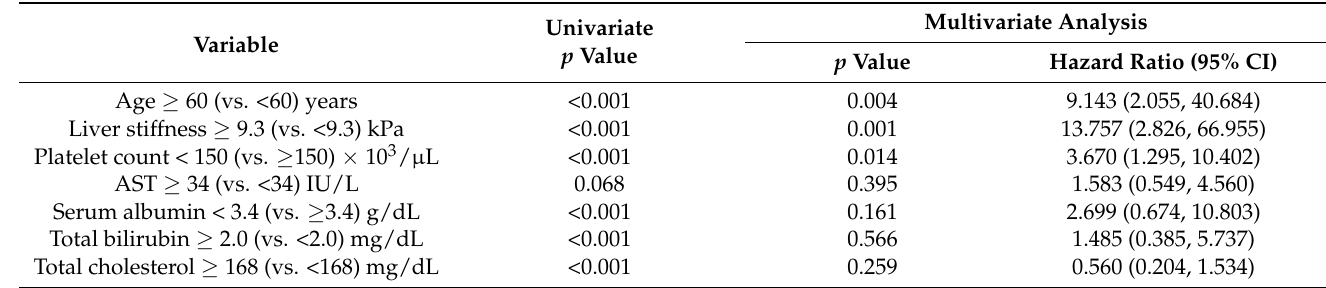
Table 2. Cox multivariate analysis for HCC